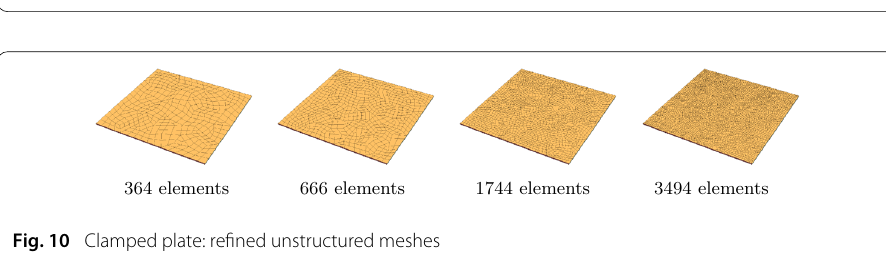
Fig. 9 Clamped plate: geometry, coarsest unstructured mesh, deformed configuration and the boundary conditions